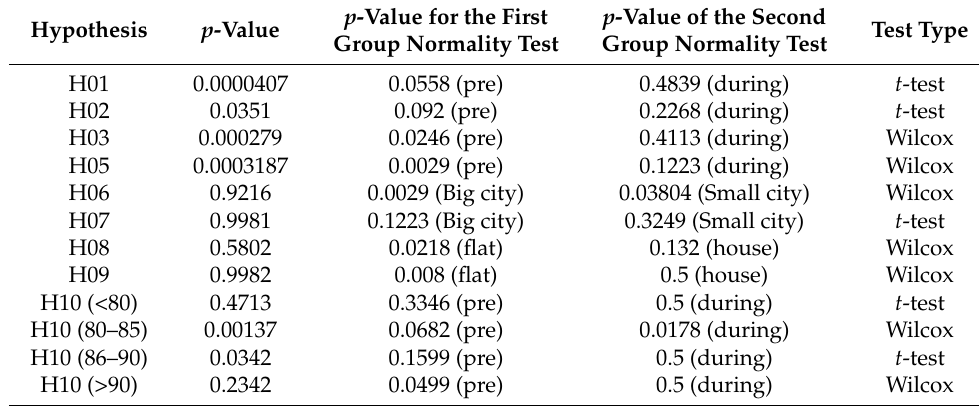
Table A1. Statistical p -values for each hypothesis.